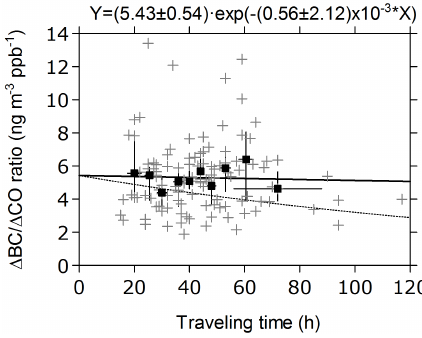
Figure 6. (cid:49) BC /(cid:49) CO ratio satisfying APT = 0mm plotted against traveling time to determine possible loss of BC from dry deposition. Raw data (gray plus signs) and 10-bin averages sorted by traveling time (black solid squares) are shown. Exponential decay fitting re- sult is shown by the black solid line. Theoretical decay with a dry deposition velocity of 0.1cms − 1 is shown by a dotted